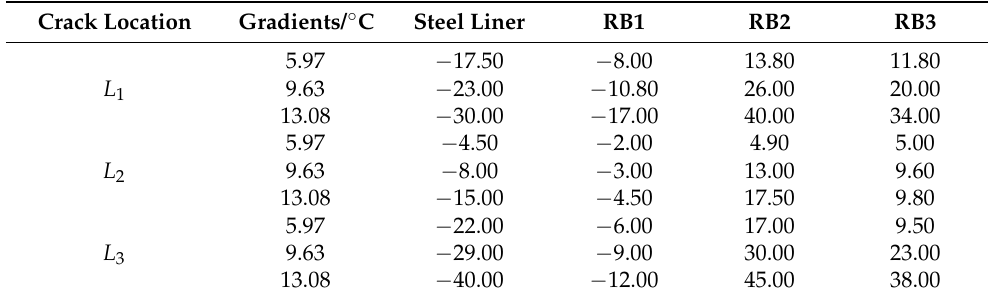
Table 4. Thermal steel stress around the crack exposed to temperature field B (unit: MPa). Crack Location